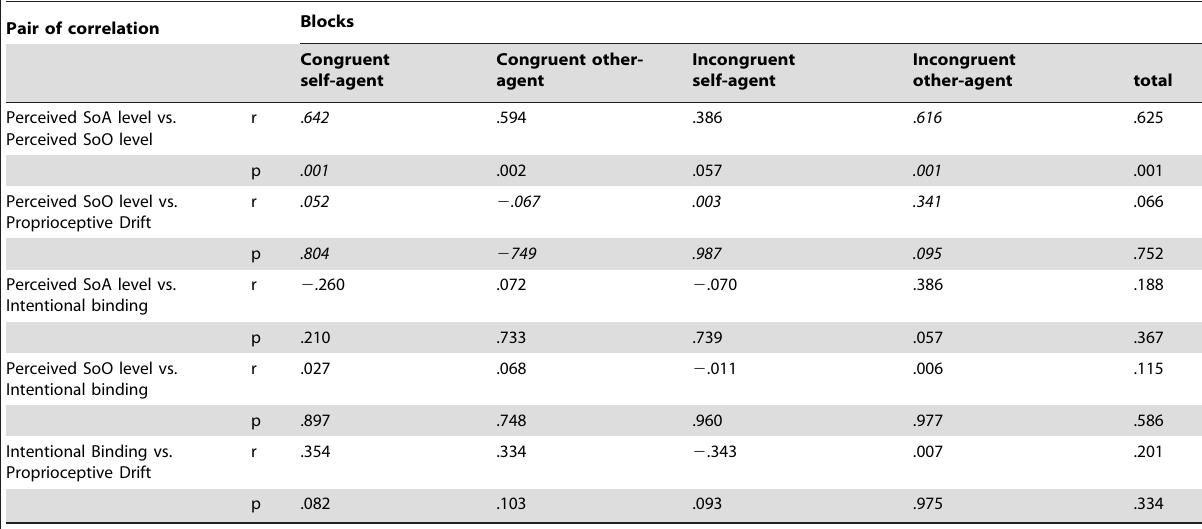
Pair of correlation